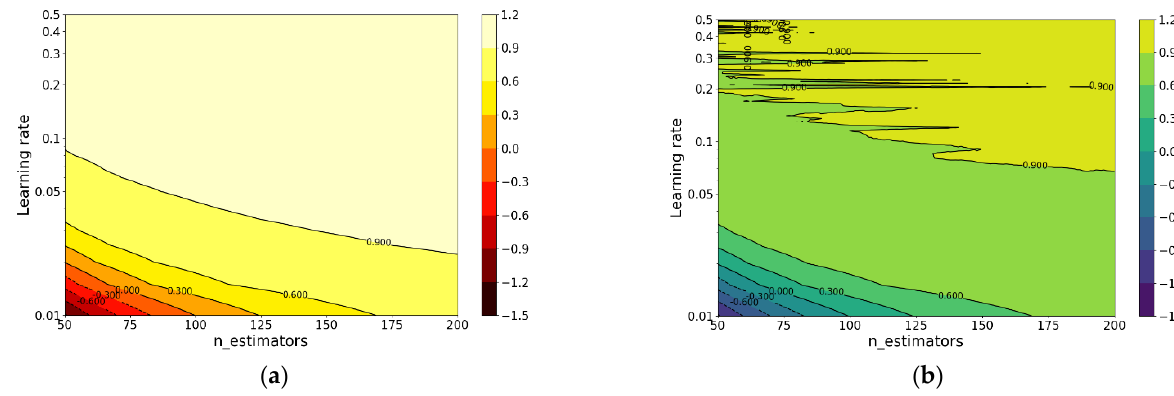
Figure 8. R-square of XGBoost under different n_estimators and learning_rate: ( a ) training set and ( b ) test set.